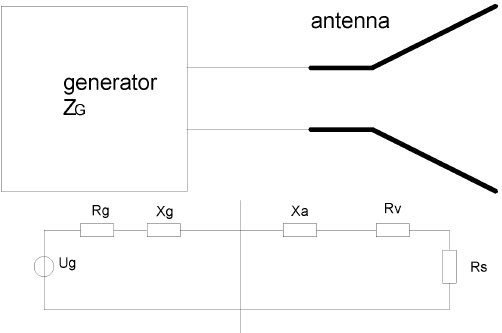
FIGURE 5 Circuit including source